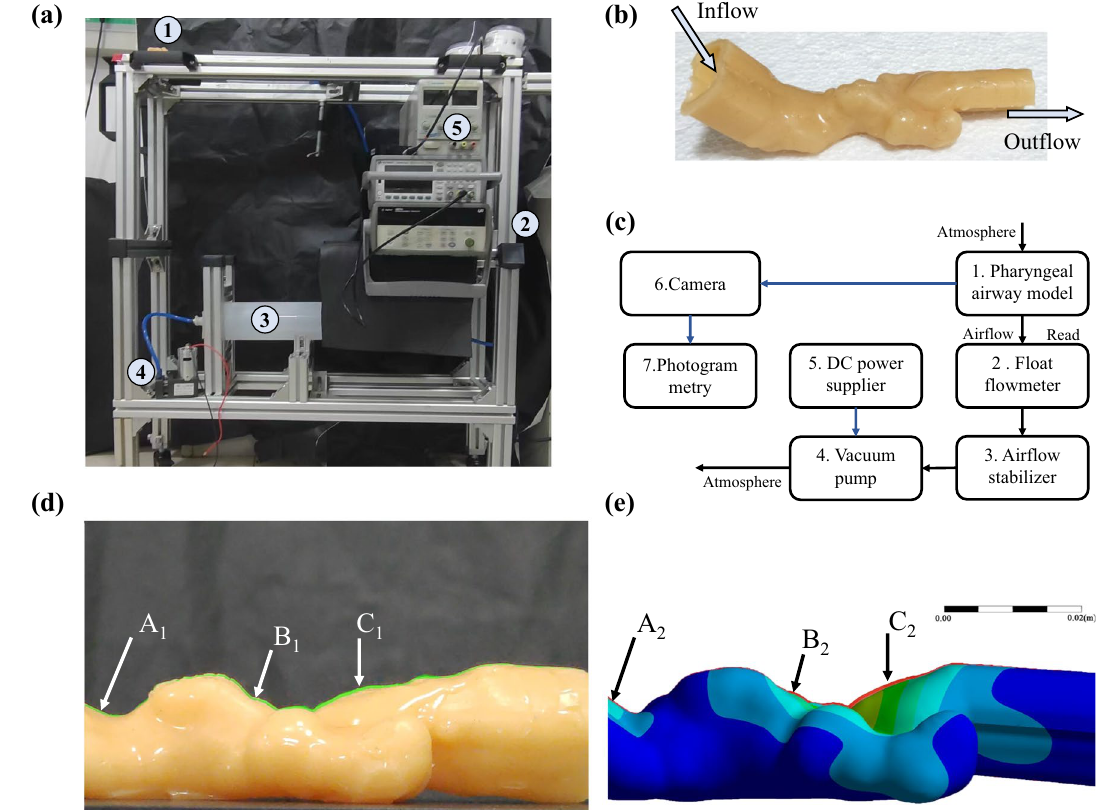
Figure 9. ( a ) Experimental facility for airway deformation measurements in the flexible pharyngeal airway model. (1) The flexible pharyngeal airway model model; (2) Float flowmeter; (3) Airflow stabilizers; (4) Vacuum pump; (5) DC power supplier. ( b ) Flexible UA model. ( c ) Schematic diagram of the experimental facility. The pharyngeal airway deformation of ( d ) Experiment, and ( e ) Simulation. The initial shapes were drawn in green and red. Note that the airway structure was set up as a tube of uniform thickness, so the tongue weight was not considered in this experiment. See the deformation measured in six probes as follow. A1 = 0.390